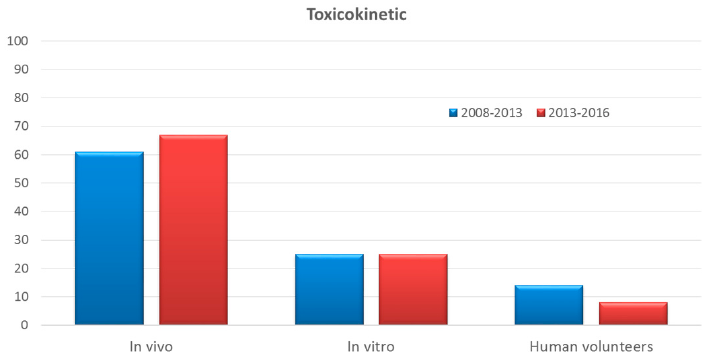
Figure 8. Evolution of the percentage of studies performed in vivo, in vitro and in human volunteers to evaluated toxicokinetic of cosmetic ingredients—number of studies 56 (2008–2013) and 36 (2013–2016).